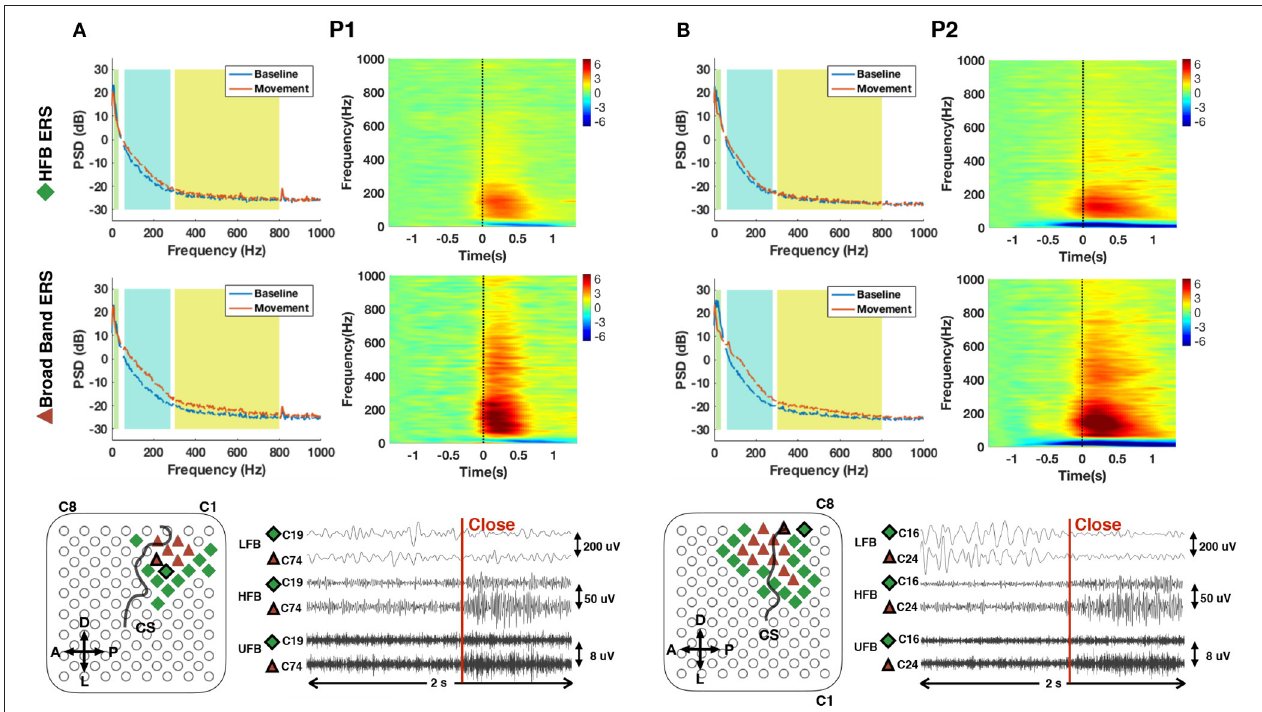
FIGURE 6 | Average power spectral density (PSD) and normalized time frequency maps of channels with exclusively significant HFB ERS (upper row) and broad band ERS (middle row) for P1 (A) and P2 (B) . LFB (8–32 Hz), HFB (60–280 Hz) and UFB (300–800 Hz) ranges are shaded in different background colors in the PSD plots. All time frequency maps were displayed from 6 to − 6 dB. Channels with significant HFB ERS and broad band ERS are represented by green diamond and red triangle, respectively, on the grid of the bottom row. Central sulcus (CS) was marked by a black curve. Orientations were denoted by “A” (anterior), “P” (posterior), “D” (dorsal) and “L” (lateral). An epoch of 2 s of subband filtered signal around movement onset (close) from neighboring channels with different ERS characteristics is also shown at the bottom row for P1 (C19, C74) and P2 (C16, C24). The locations of the channel pairs are highlighted on the grid. The scale of each subband is provided on the right side of the data